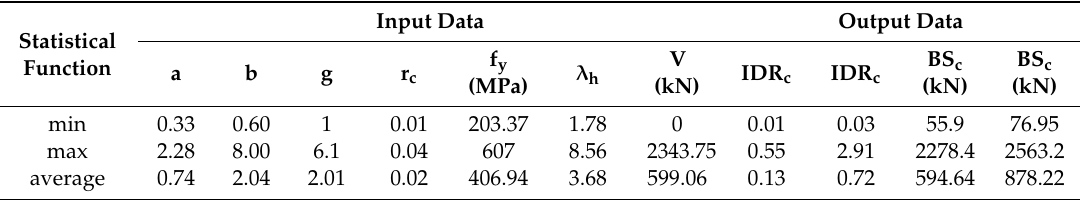
Table 2. The range of input and output data in the EDIF Database.